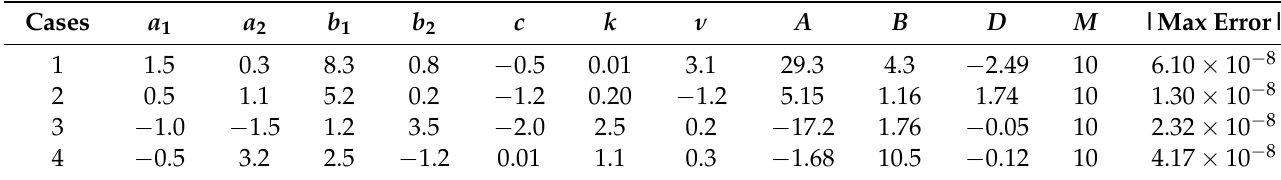
Table 1. Parameters used for simulating